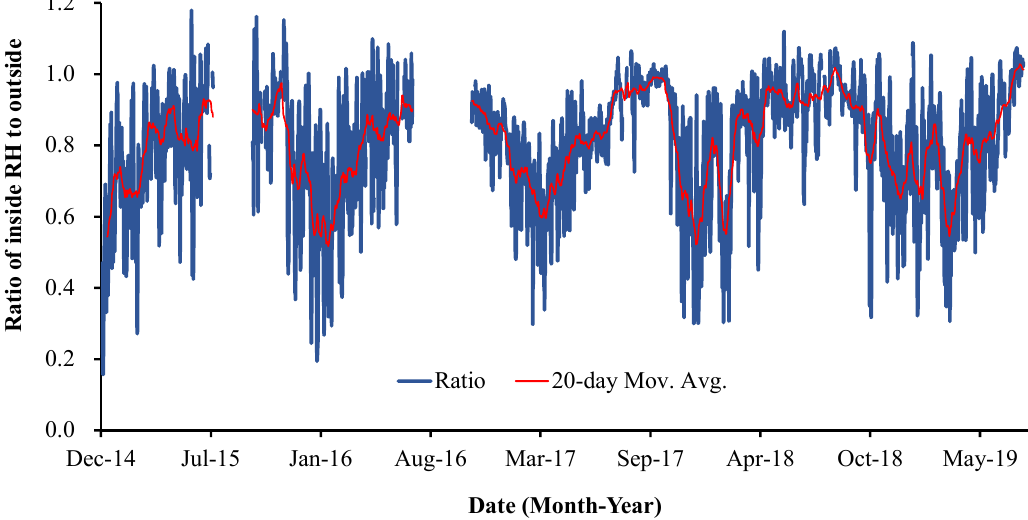
Figure 5 . The ratio of outside daily mean relative humidity to that inside the sunken solar greenhouse during the seven seasons. Thin solid red line represents the 20-day moving average.